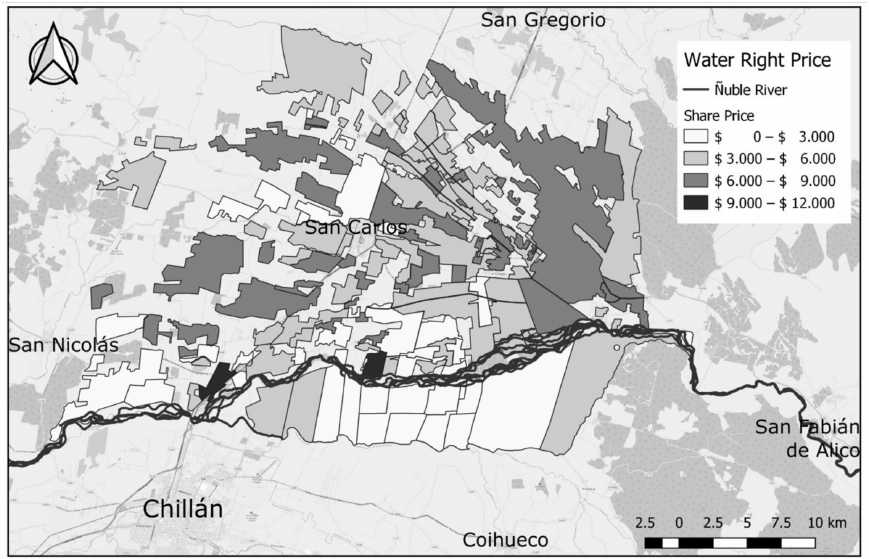
Figure 7. Geographic price dispersion of water use rights (WUR) in ÑRIS. Share price for water rights by canal in the Ñuble River irrigation